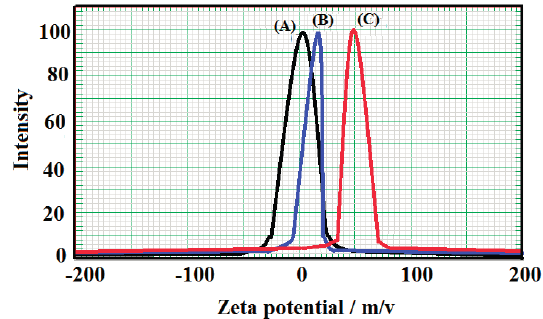
Figure 9. Zeta potential of (A) magnetite; (B) magnetite coated with R/AN and (C) magnetite RK/AN coated with amidoximes in (ethanol/water; 60/40 volume %) 1 mM KCl at pH =